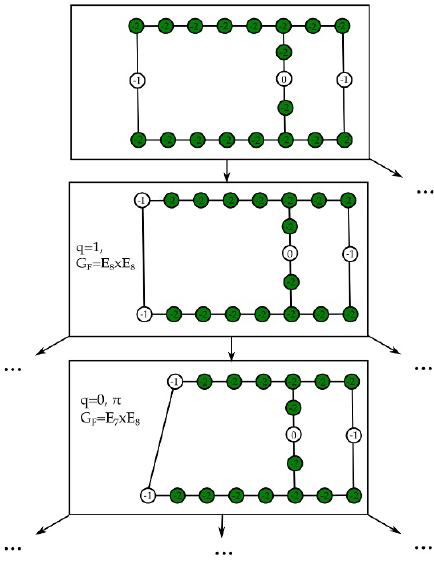
Figure 18 . Subtrees of the (E 8 ; E 8 ) CFD-tree of theories that have a quiver description, including the theta angles. The full CFD-tree can be seen in [89] and has 127 descendants. The theories that have a known quiver description, and comprise a small subset, are shown here.